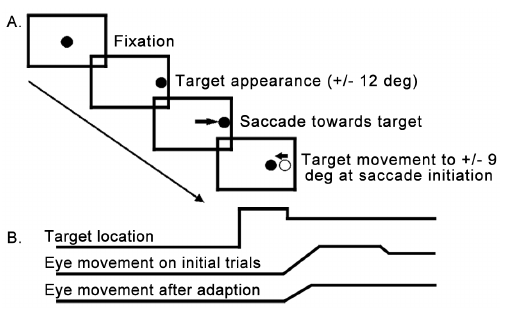
Figure 1. Schematic representations of the saccade adaptation test. A.) Participants were instructed to shift their gaze to peripheral targets when they appeared. After subjects initiated their saccade, the target stepped inward from the 6 12 deg location to 6 9 deg in the same visual hemifield. B) Schematic representations of double-step target displacement and traces of non-adapted and adapted saccades.